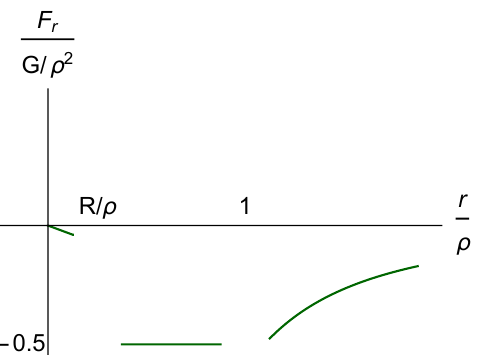
, plotted against the (cid:26) 2